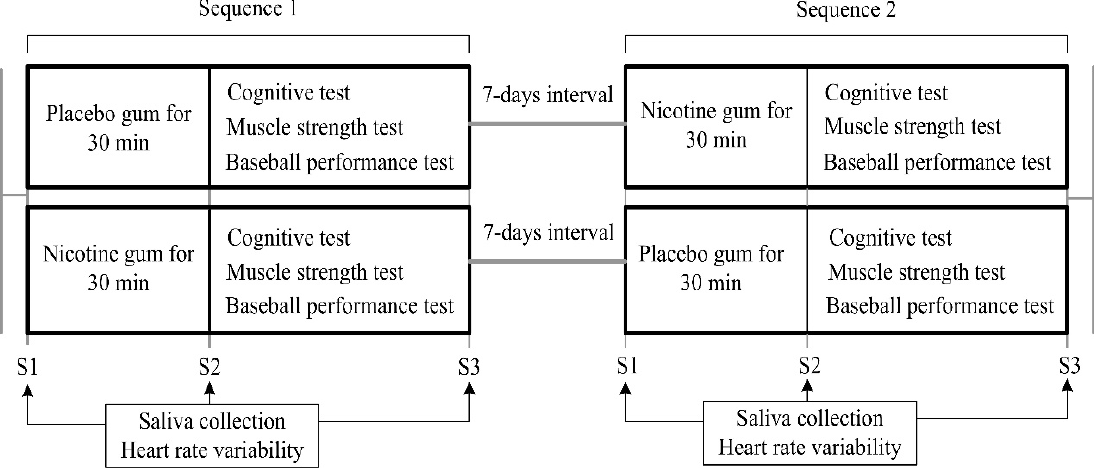
Figure 1. Experimental protocol.